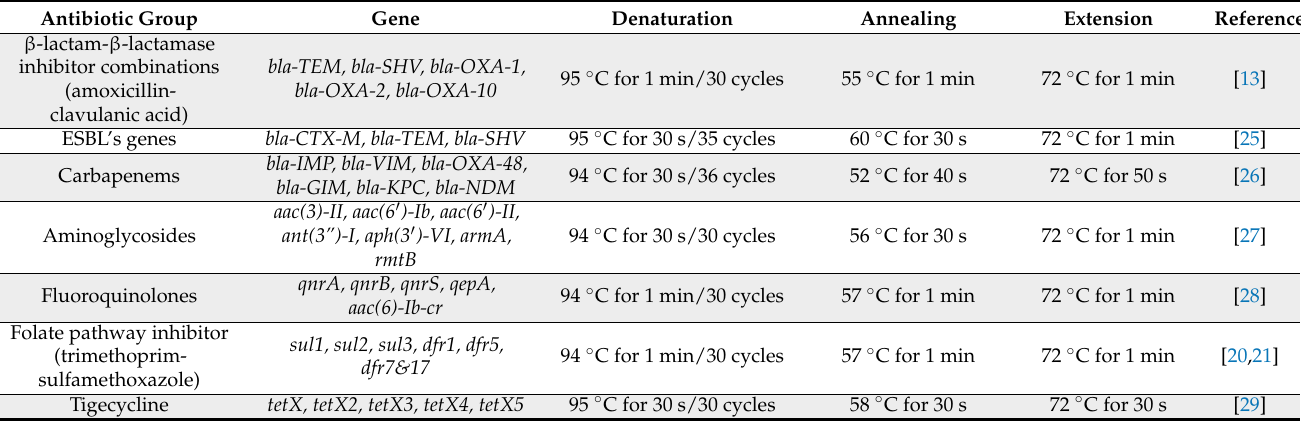
Table 2. The PCR cycles performed for each antibiotic